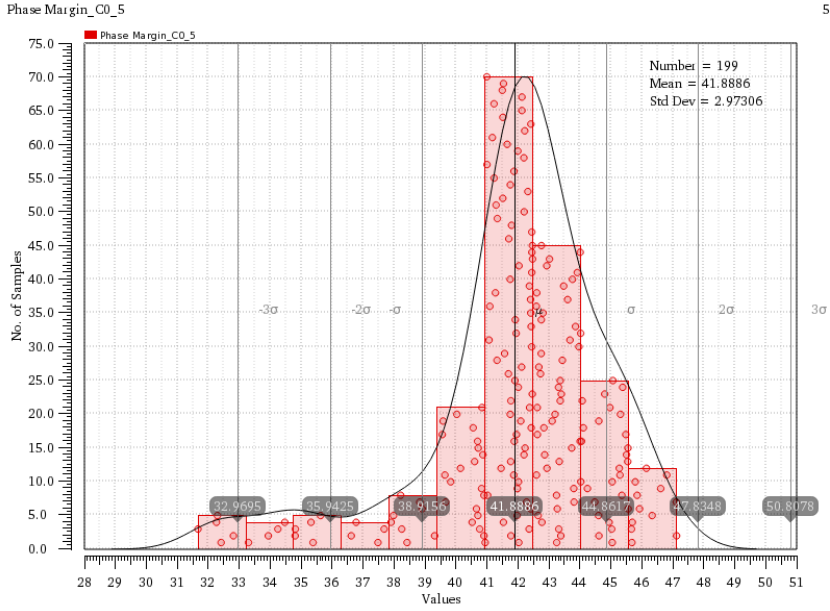
Figure 7. Monte Carlo simulation results of phase margin at 1 mA load current.